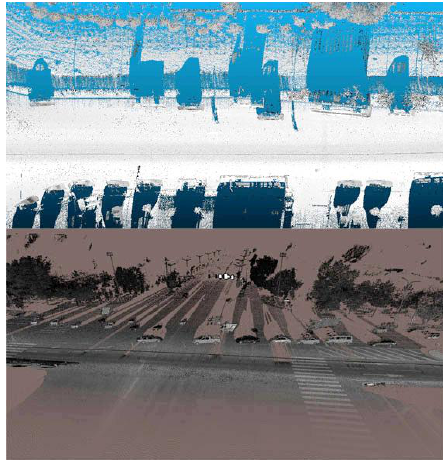
Figure 9. Cars parked at the roadside